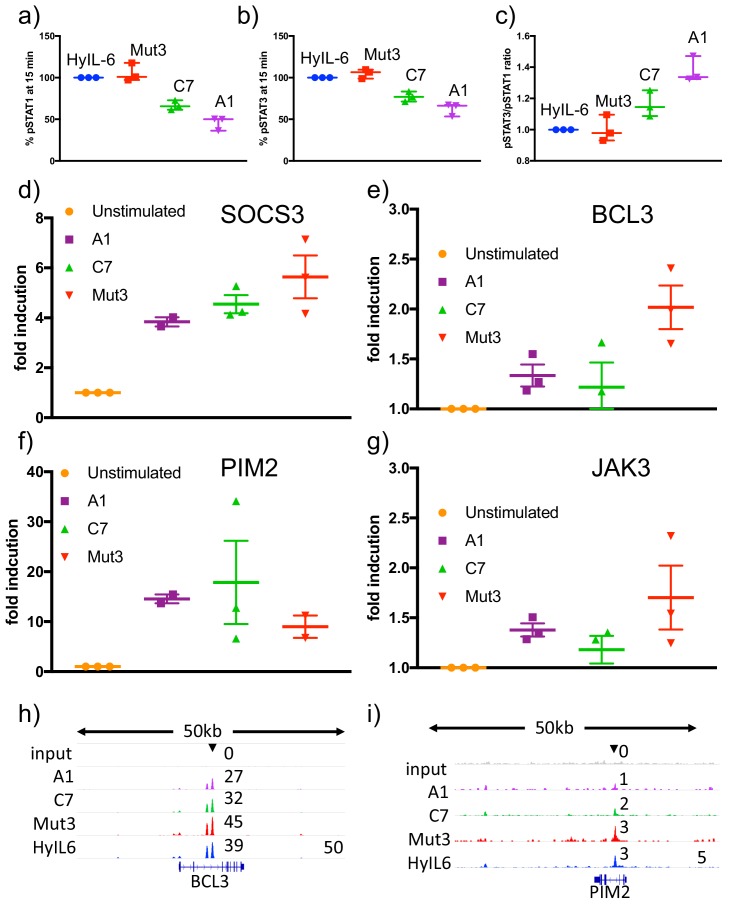
Transcriptional characterization of IL-6 variants.(a–c) Human CD4 T cells were isolated from buffy coats and differentiated into Th1 cells for five days. 24 hr before stimulation, cells were starved of cytokines. Starved-Th1 cells were stimulated with saturating doses of the indicated IL-6 ligads for 15 min and the levels of STAT1 (a) and STAT3 (b) activation were measured by Phospho-Flow cytometry. The pSTAT3/pSTAT1 ratio resulting from these studies is plotted in panel (c). Data are mean + /- SEM from three independent donors. (d–g) Th1 cells generated as in (a–c) were stimulated with saturating concentrations of the indicated IL-6 ligands for six hours. RNA was extracted at that point and converted to cDNA to perform qPCRs studies. The levels of the indicated STAT3-induced genes were quantified. (h–i) STAT3 binding to BCL3 (h) and PIM2 (i) promoters in response to stimulation with the different IL-6 variants in Th1 cells.